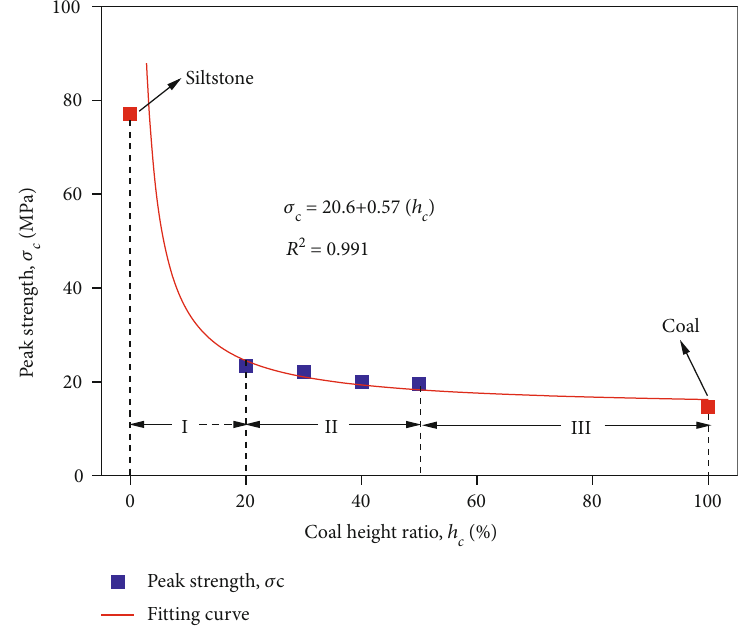
Figure 5: Relation between peak strength of RCRCS and coal height ratio.